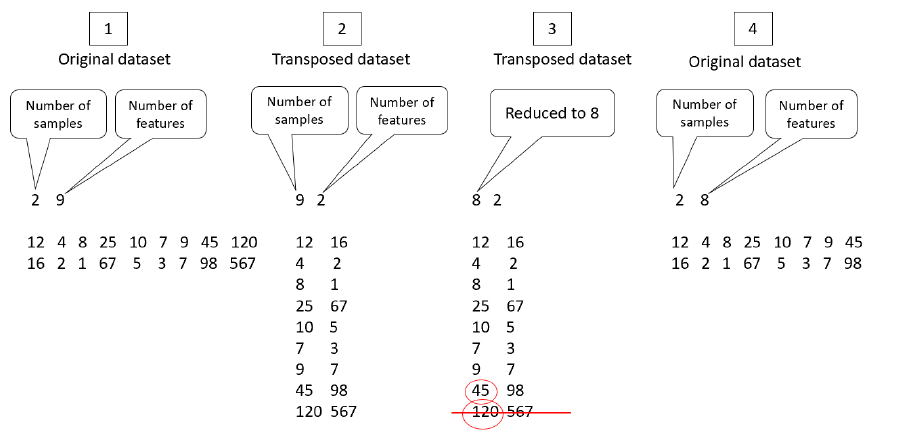
Figure 2. An example of PPFS